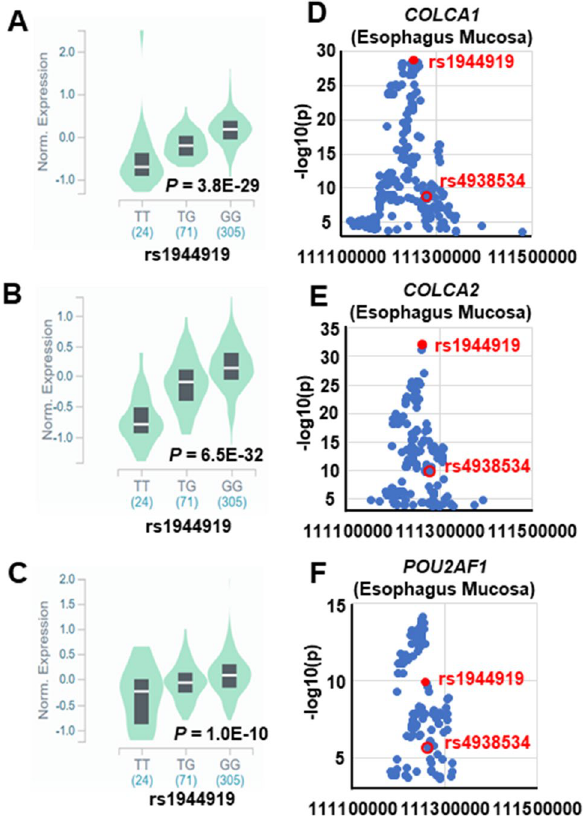
Figure 2. rs1944919 genotypes are associated with differences in endogenous COLCA1 , COLCA2 , and POU2AF1 expression levels. ( A–C ) Effect of the rs1944919 genotype on endogenous expression of COLCA1 ( A ), COLCA2 ( B ), and POU2AF1 ( C ) in the esophageal mucosa. ( D–F ) e-QTL mapping of COLCA1 ( D ), COLCA2 ( E ), and POU2AF1 ( F ) in the esophageal mucosa. rs1944919, shown as red solid dots, exhibited the strongest association with COLCA1 and COLCA2 expression. Red open dots indicate rs4938534 which was the most significant SNP with PBC susceptibility on chromosome